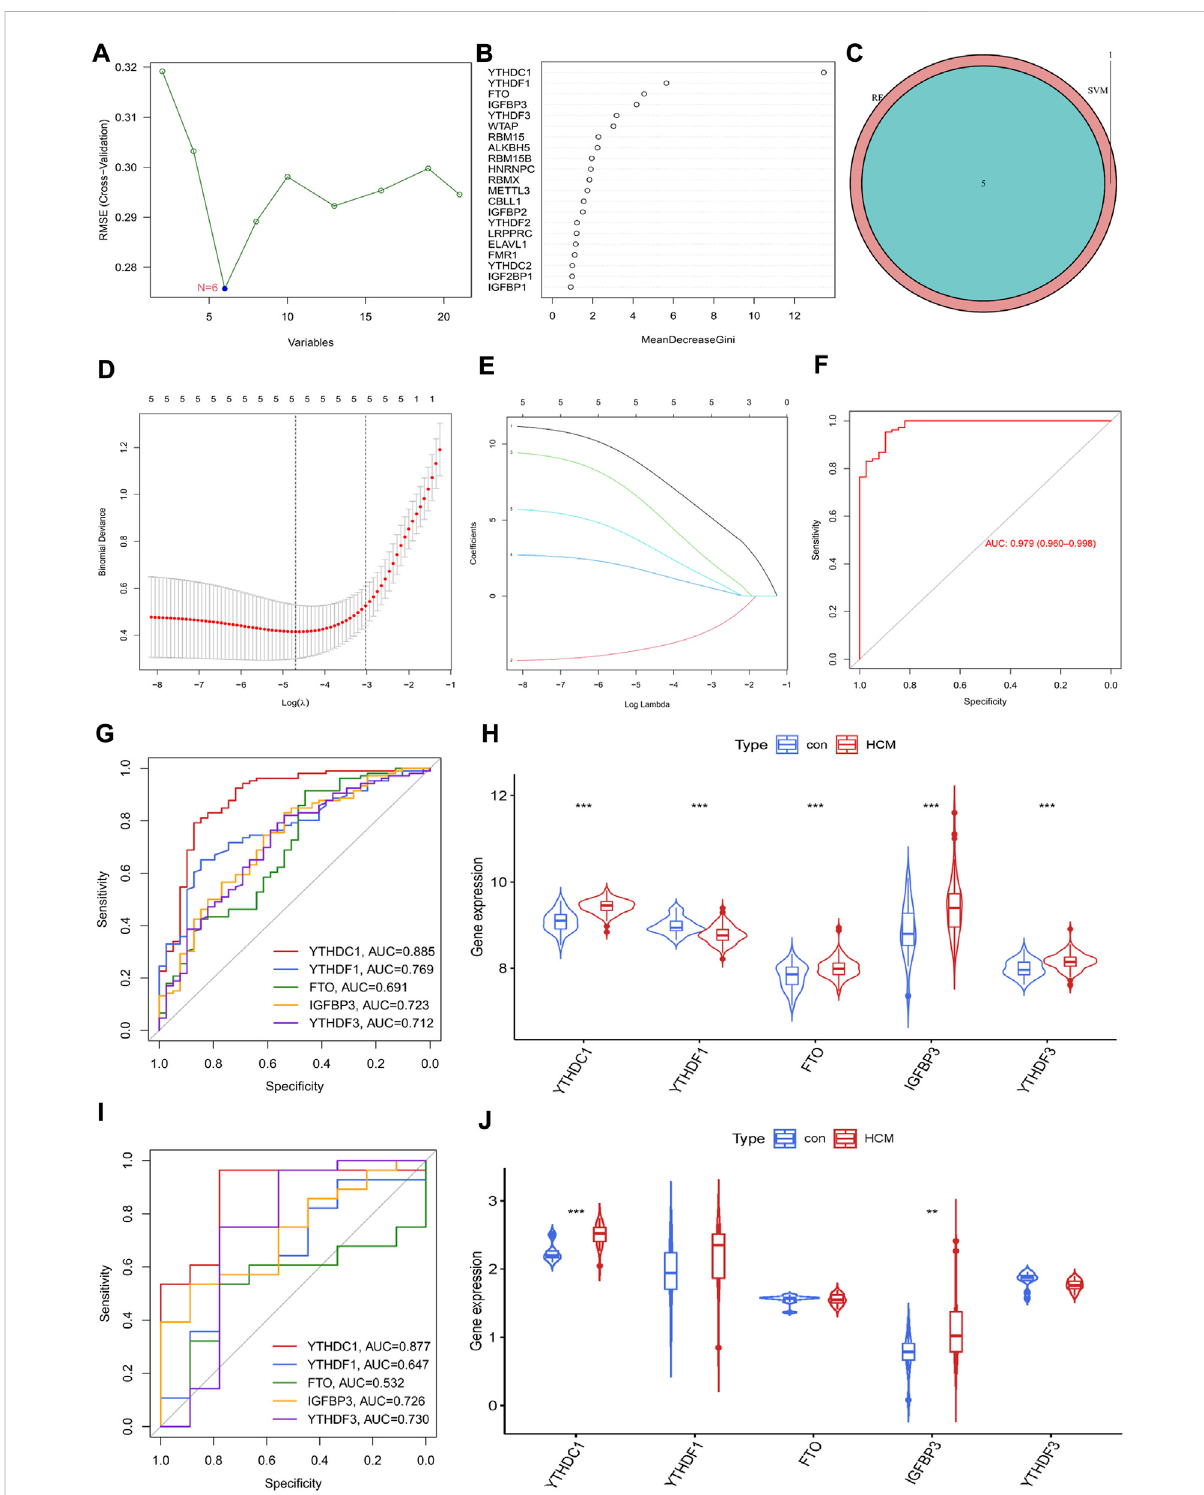
FIGURE 3 Identi fi cation of m6A Regulator as biomarkers of hypertrophic cardiomyopathy. (A) Selection of signi fi cant m6A regulators by support vector machine recursive feature elimination (SVM-RFE) model. (B) Selection of signi fi cant m6A regulators by random forest (RF) model. (C) Venn diagram of fi ve overlapped candidate genes shared by the SVM-RFE and RF algorithms. (D,E) Least absolute shrinkage and selection operator (LASSO) coef fi cient pro fi les of hub genes and cross-validation of the model. (F) receiver operating curves (ROC) of LASSO model in GSE36961. (G,H) ROC assessment and difference analysis (Wilcox rank sum test) of thecandidate biomarkers using GSE36961. (I) Validation of the diagnostic value of candidate biomarkers using GSE130036. (J) The expressions of candidate diagnostic biomarkers in the GSE130036 dataset (Wilcox rank sum test). * p < 0.05, ** p < 0.01, *** p <